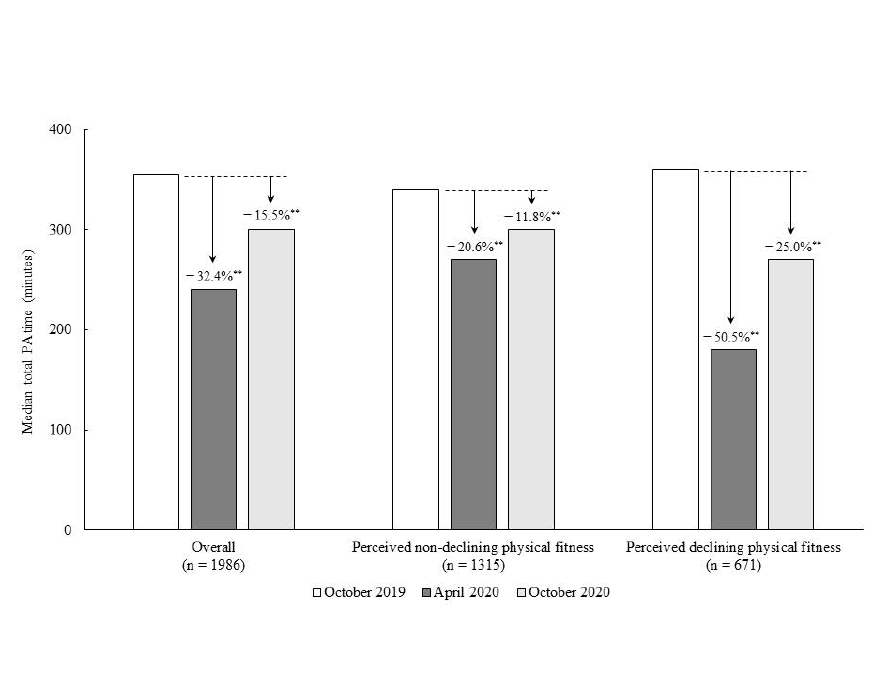
Figure 1. Changes in PA time in April and October 2020 compared with October 2019 in participants with and without a perceived decline in physical fitness. **: statistical significance ( p < 0.01) compared with October